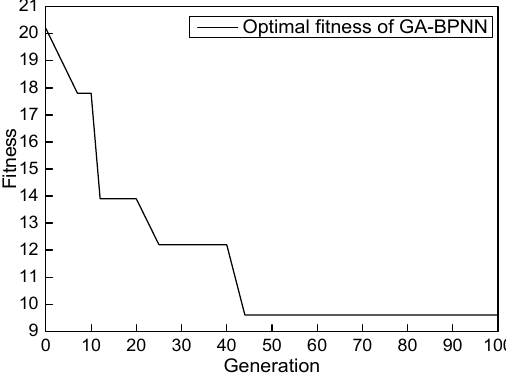
Figure 8. The fitness curve of Genetic algorithms.